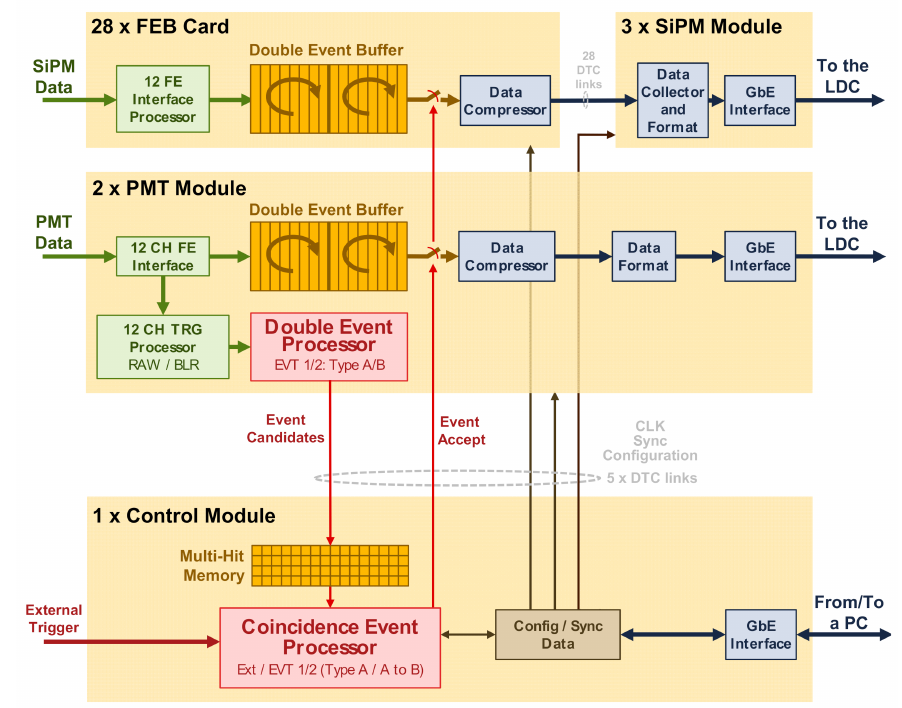
Figure 4. NEXT-DEMO trigger